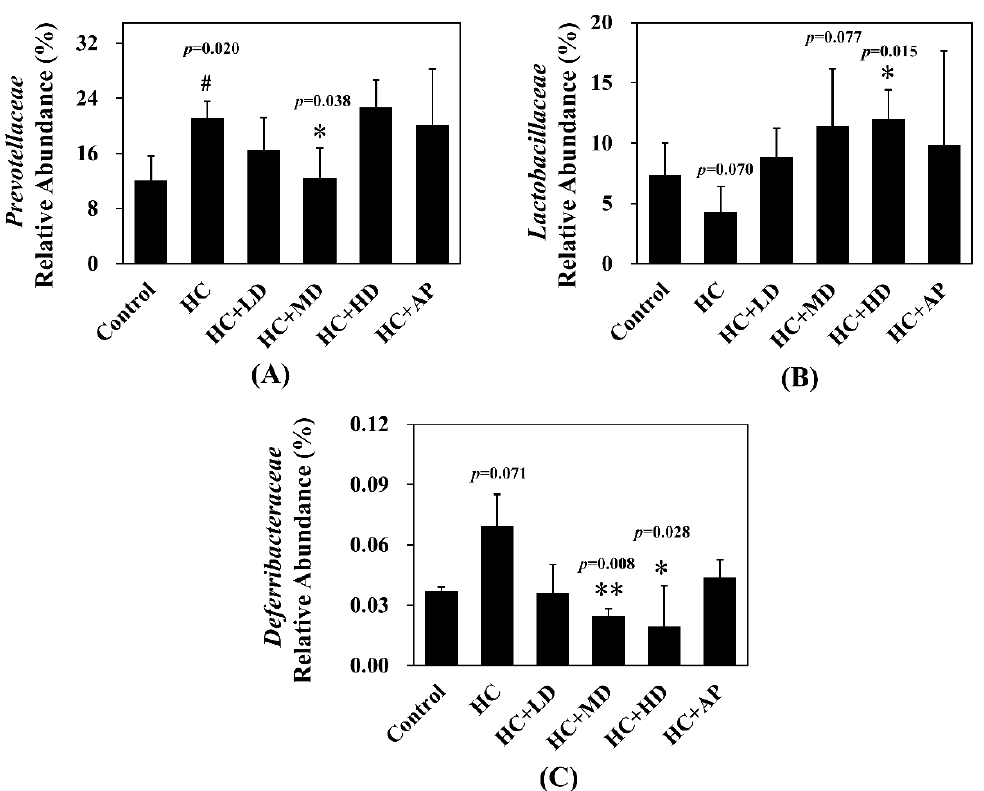
Figure 6. Effect of TCI227 on relative abundances of Prevotellaceae ( A ), Lactobacillaceae ( B ), and Deferribacteraceae ( C ) in feces. The reported values are means ± SD (n = 3); # significantly differs from the HC group ( p < 0.05); * significantly differs from the HC group ( p < 0.05); ** significantly differs from the HC group ( p <